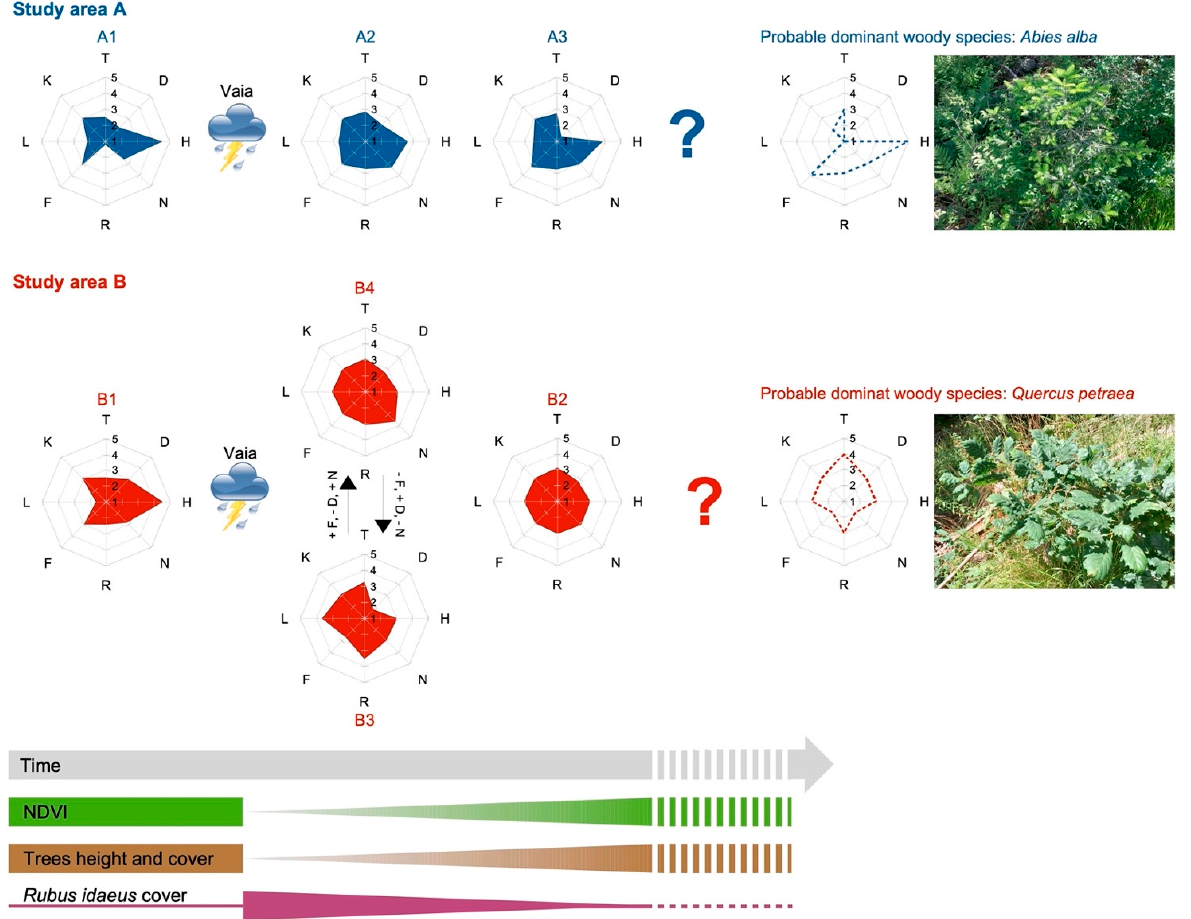
Figure 8. Models of plant succession trends of the two study areas (A, Val Malga; B, Vione). The models show the radar charts of the ecological indices of Landolt et al. [35] of each plant community and the schematic trend of NDVI, tree height and cover, and Rubus idaeus cover. The values of the ecological indexes of the two probable dominant woody species (broken line in the radar chart) of the mature forest community and a photograph of them in the two study areas are reported. Key of the ecological indexes: T, temperature; K, continentality; L, light intensity; F, soil moisture; R, sub-